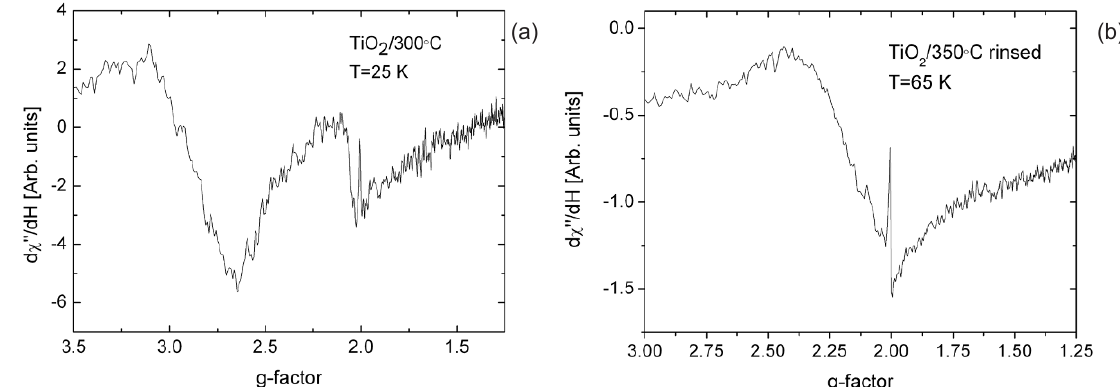
Figure 7. EPR spectra of broad component in samples [TiO